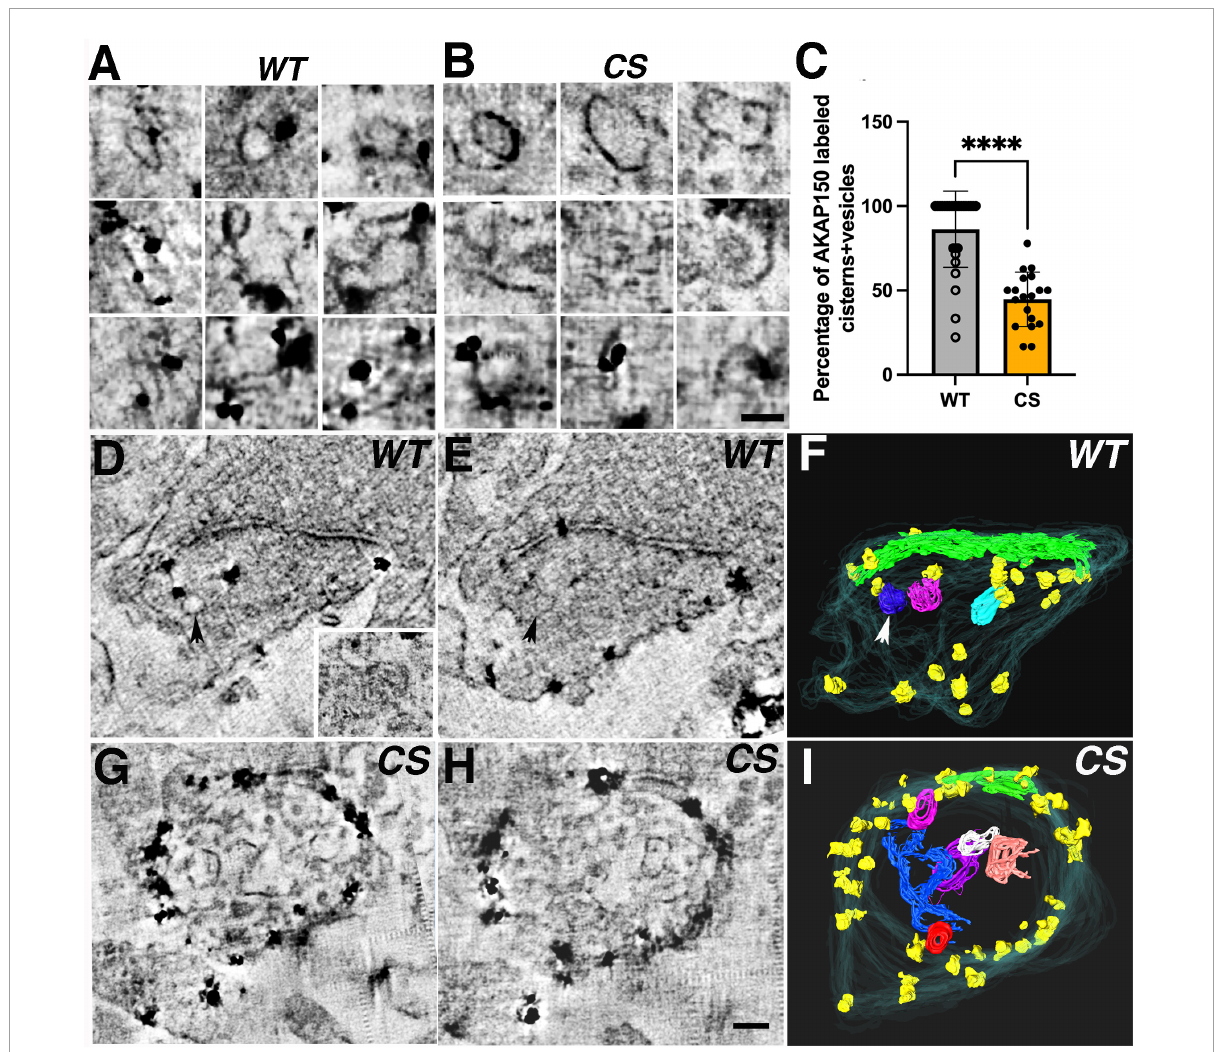
FIGURE6 AKAP150 labeled endosomal structures in spine synapses revealed by STEM tomography. (A) In WT spines, 3 × 3 image gallery of AKAP150 immunogold labeled endosomal structures (e.g., large vesicle, coated vesicle, amorphous cistern, tubular cistern) from projections of 5–9 averaged virtual sections. (B) In CS spines, 3 × 3 image gallery of vesicles, coated vesicles and cisterns not associated with AKAP150 labels but some endosomal structures (vesicles and tubules) are still immunogold labeled for AKAP150. Scale bar 100 nm. (C) Percentage of AKAP150 labeled endosomal structures are reduced in CS compared with WT (Mann-Whitney test, ∗∗∗∗ P < 0.0001, WT, 27 spine synapses in 8 STEM tomography reconstructions: CS, 20 spine synapses in 6 STEM tomography reconstructions). (D–F) AKAP150 labeled WT spine synapse reconstructed by STEM tomography. (D) A virtual section of the AKAP150 labeled spine synapse, arrow points to an immunogold labeled vesicle. Inset: a multi-vesicular body associated with a tubule labeled for AKAP150, a typical endosomal structure. (E) A neighboring virtual section close to (D) , arrow point to the same labeled vesicle. (F) Surface rendering of the AKAP labeled dendritic spine from the tomography reconstruction. spine membrane (translucent cyan), PSD (green), immunogold particles (yellow), AKAP labeled endosomal vesicles (blue, magenta, cyan). Arrow points to the labeled vesicle in (D,E) . (G–I) AKAP150 labeled CS spine synapse reconstructed by STEM tomography showing many vesicles and cisterns in spine cytoplasm lacking AKAP150 labels. (I) Surface rendering of the spine synapse from the STEM tomography reconstruction in (G,H) . Spine membrane (translucent cyan), PSD (green), AKAP150 immunogold particles (yellow), unlabeled endosomal vesicles and cisterns (blue, red, white, purple, pink, orange). Scale bar 100